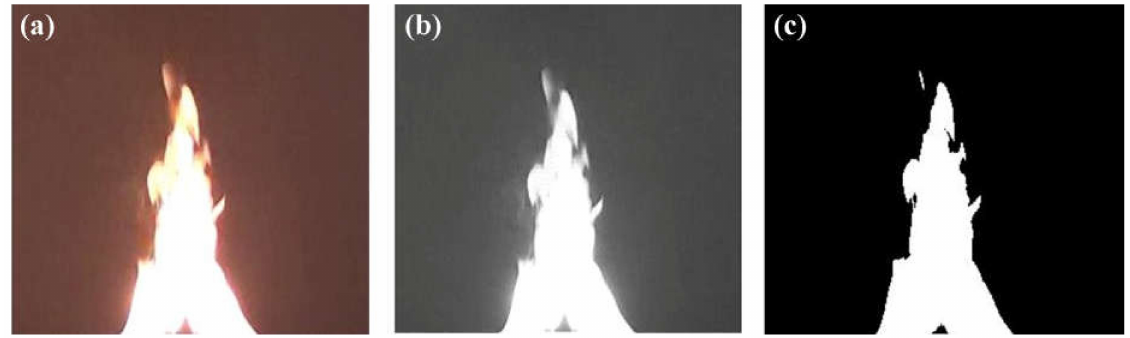
Figure 3. Flame image processing in side view: ( a ) RGB image; ( b ) grayscale image; and ( c ) binary image. The flame-merging probability P m was defined as the number ratio of flame-merging frames to the total frames during the stable phase (see also Ref. [27]). The probability of flame merging ranges from 0, corresponding to no flame merging occurs, up to 1, corresponding to flames continuously merge together. The flame-merging judgment area was 0.5 mm wide on both sides of the centerline of the two parallel line flames, and the height is the distance from the burner surface to the ceiling When the flames are merged, this region contains a flame with a length greater than 0, otherwise the flames are not merged. Figure 4 is a schematic diagram of the judgment area. The width of the judgment area was 1 mm, and the height was much larger than the flame height of two parallel line